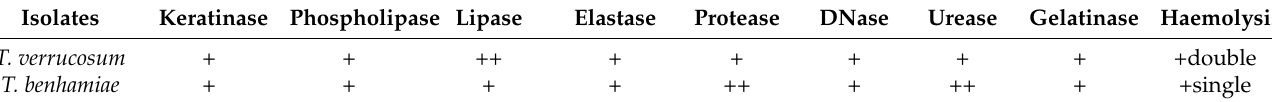
Table 3. In vitro enzymatic activity of dermatophyte isolates obtained from cattle after 21 days of incubation. Isolates Keratinase Phospholipase Lipase Elastase Protease DNase Urease Gelatinase Haemolysis